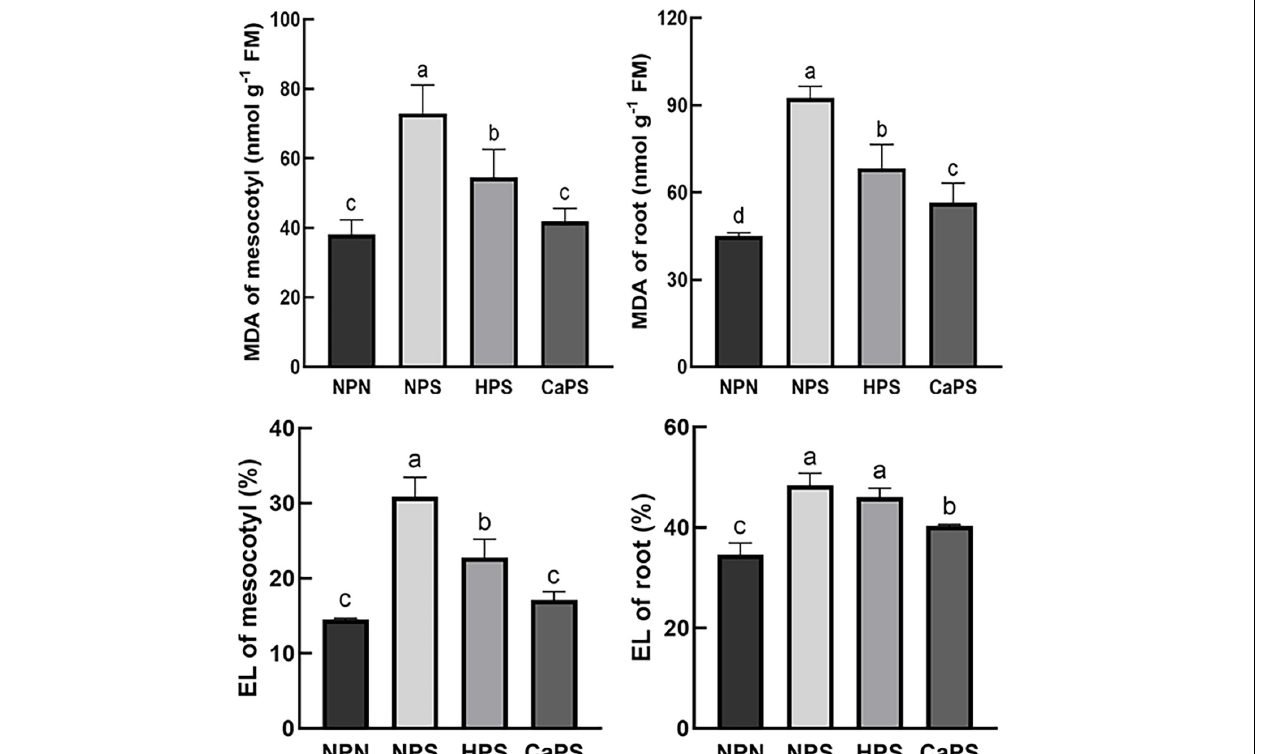
FIGURE 6 | Effect of CaCl 2 priming on MDA content and electrolyte leakage in sorghum tissue under salt stress. MDA, malondialdehyde; EL, electrolyte leakage.